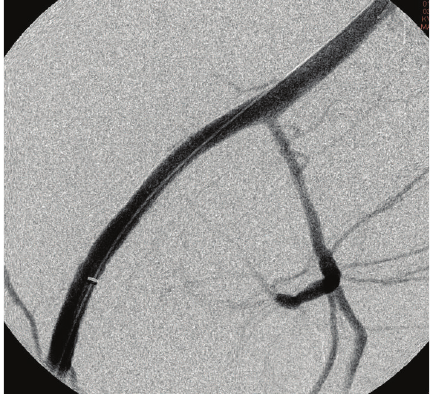
Figure3:Rightcommoniliacangiogrampoststentingdemonstrates successful treatment of arterio-jejunal